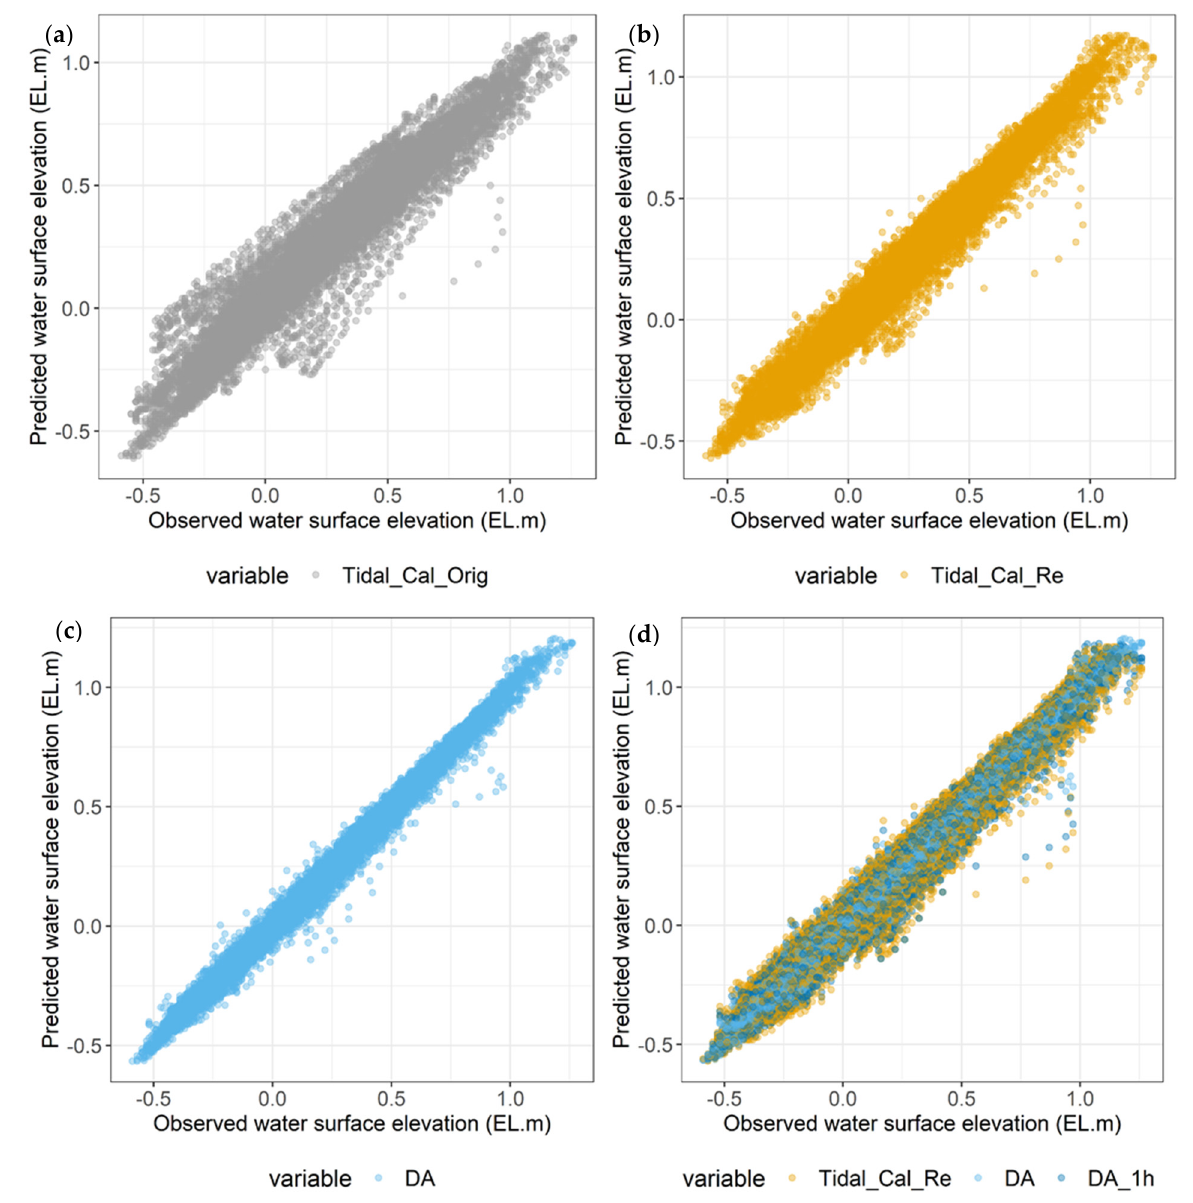
Figure 6. Comparison of the observed and predicted water surface elevations assessed by: ( a ) the TASK2K simulation (Tidal_Cal_Orig), ( b ) adjustment by the regression equation (Tidal_Cal_Re), ( c ) DA analysis at the current timestep, and ( d ) the 1 h lead forecast by DA (DA_1 h) compared with the regression and DA analysis.